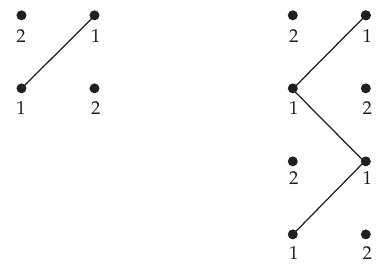
Figure 12: Tangles for E i and E i E − i E i , (cid:2) λ i ,λ i (cid:9) 1 (cid:3) (cid:8) (cid:2) 1 , 2 (cid:3) .